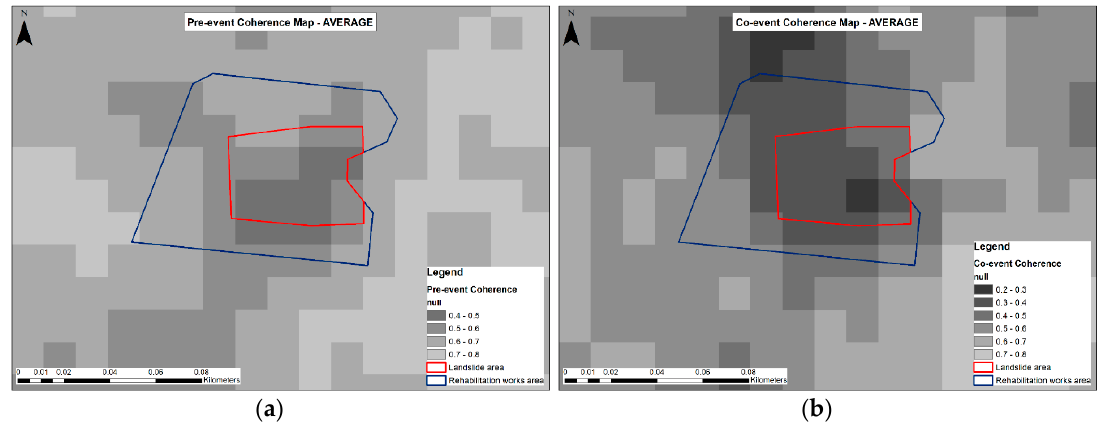
Figure 16. ( a ) Pre-event and ( b ) co-event average coherence